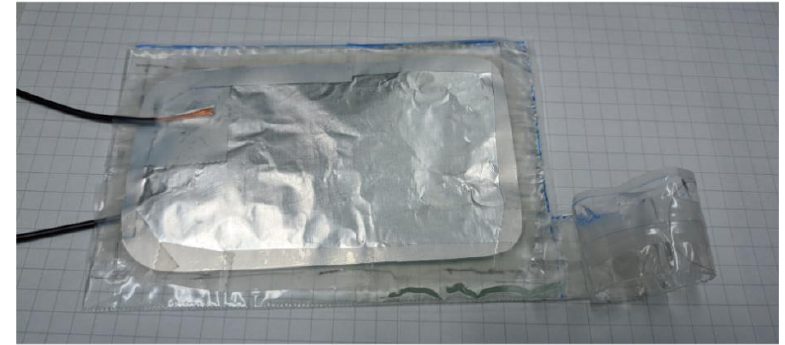
Table 1. The geometric parameters of the spiral spring.